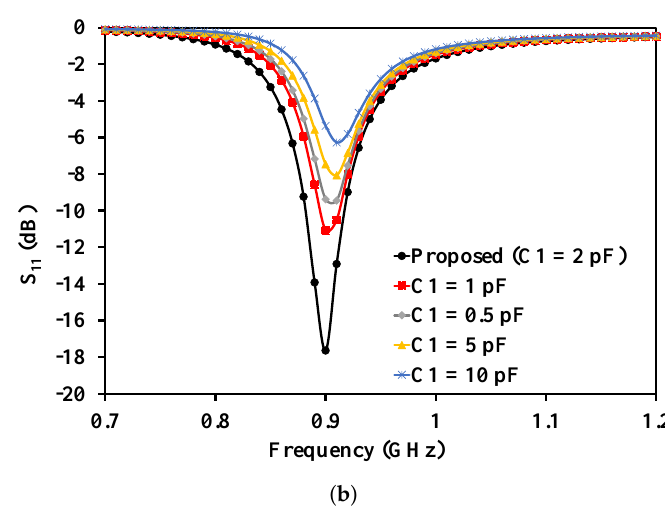
Figure 4. Simulated reflection coefficient of the rectifier for: ( a ) Inductance ( L 1) ( b ) Capacitance ( C